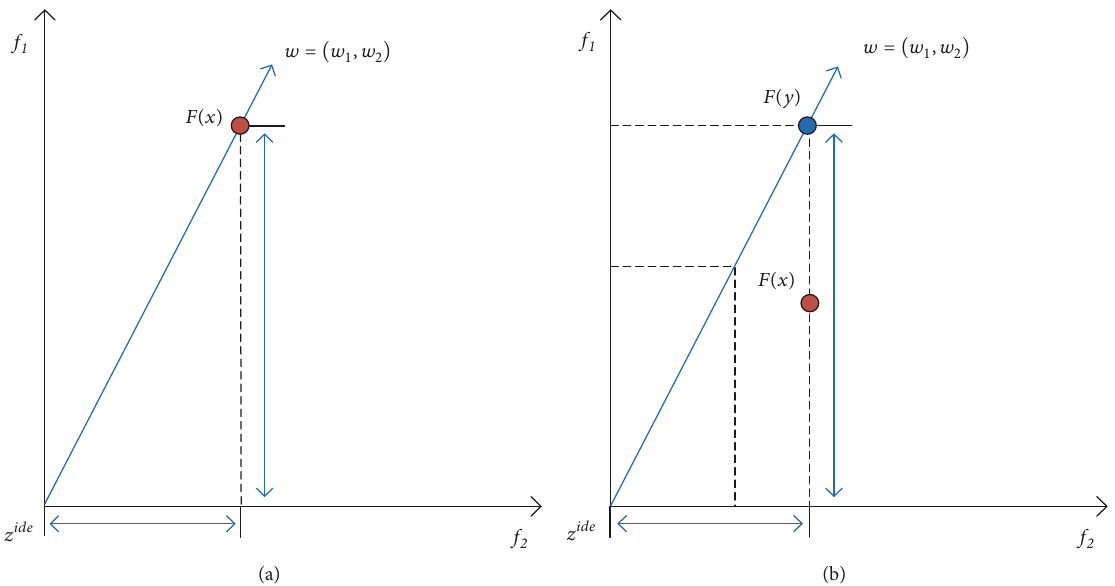
Figure 1: Tchebycheff decomposition with the ideal reference point for the cases: (a) F ( x ) is located in the line L 1 . (b) F ( x ) is not located in the line L 1